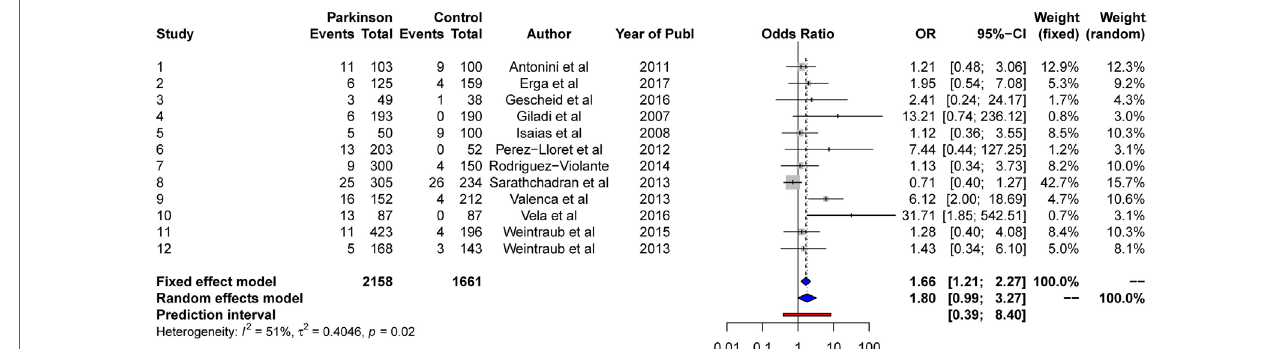
FigURe 8 | Forest plot for